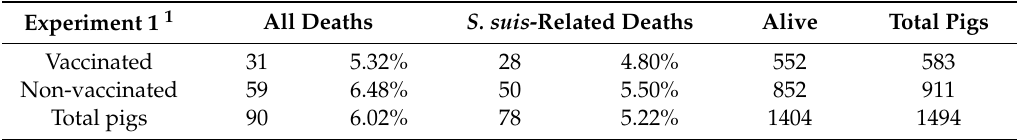
Table 1. Distribution of mortality among vaccinated and non-vaccinated piglets.